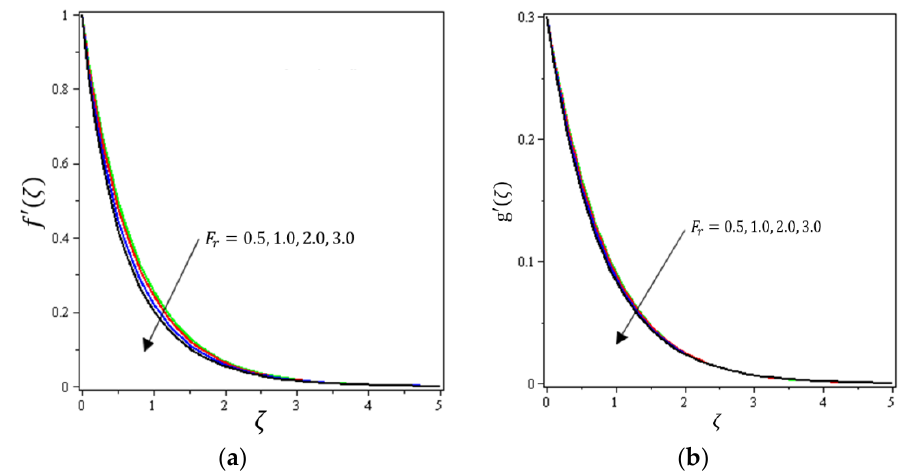
Figure 3. Influence of Darcy–Forchheimer number 𝐹 (cid:3045) on velocities ( a ) 𝑓′(𝜁) and ( b ) g ′(𝜁) .